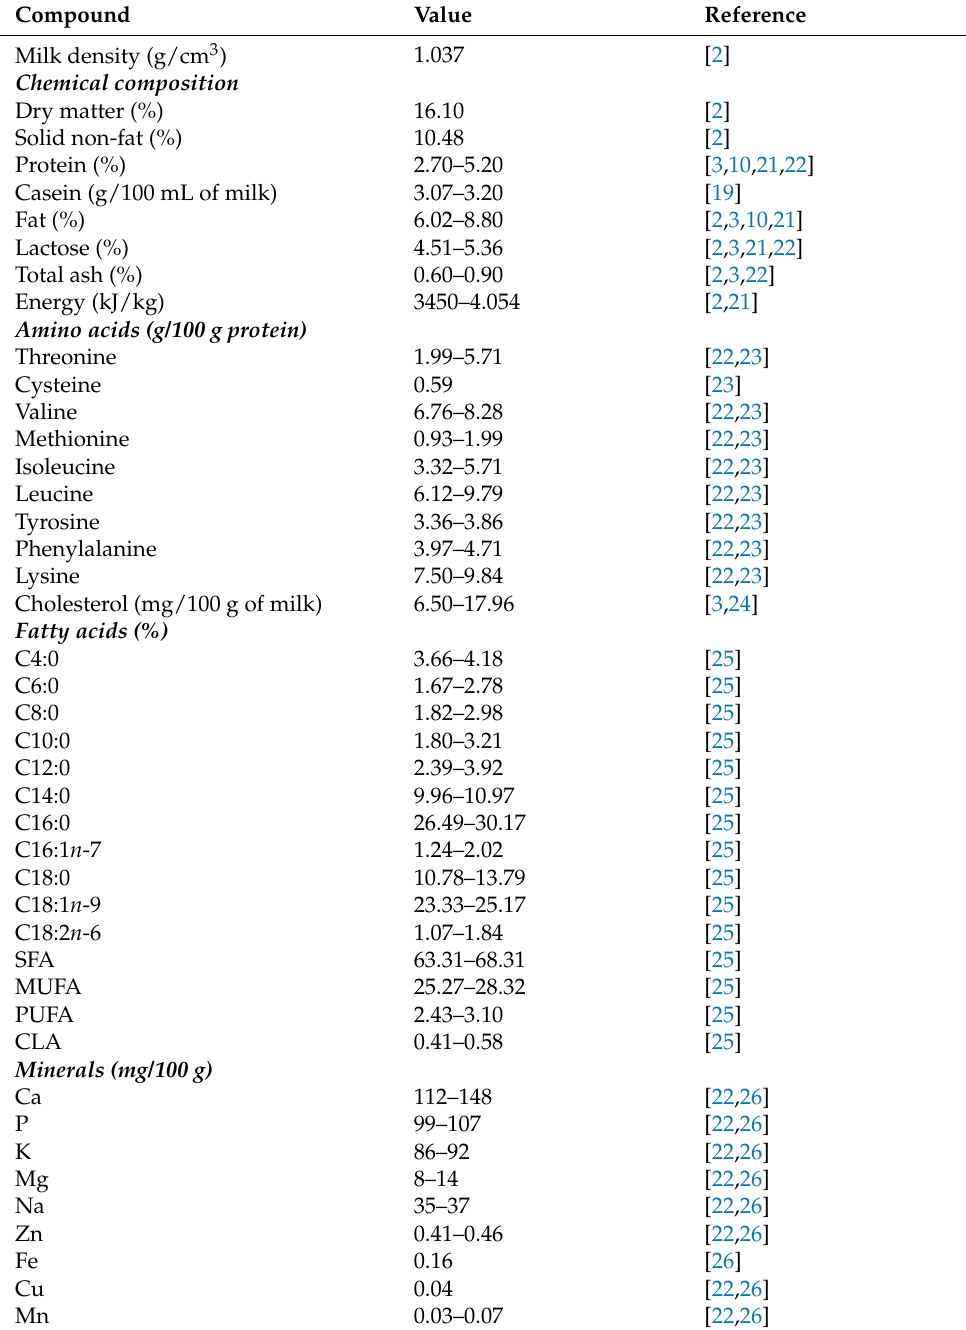
Table 1. Buffalo ( Bubalus bubalis ) milk chemical composition and nutritional